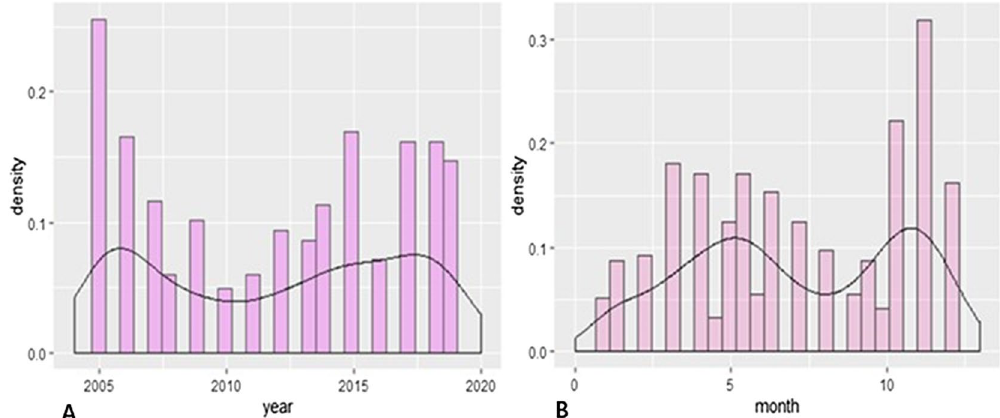
Figure 1. (A) Distribution of the annual number of cases from 2005 to 2019. (B) Distribution of the monthly number of cases from 2005 to